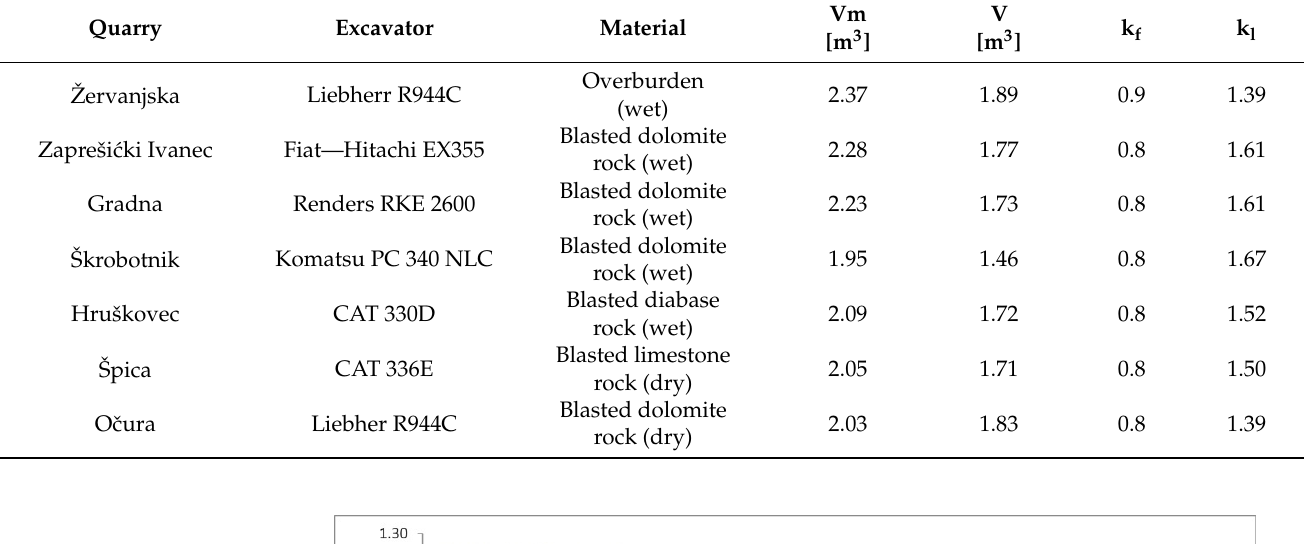
Table 3. Loosening factor.